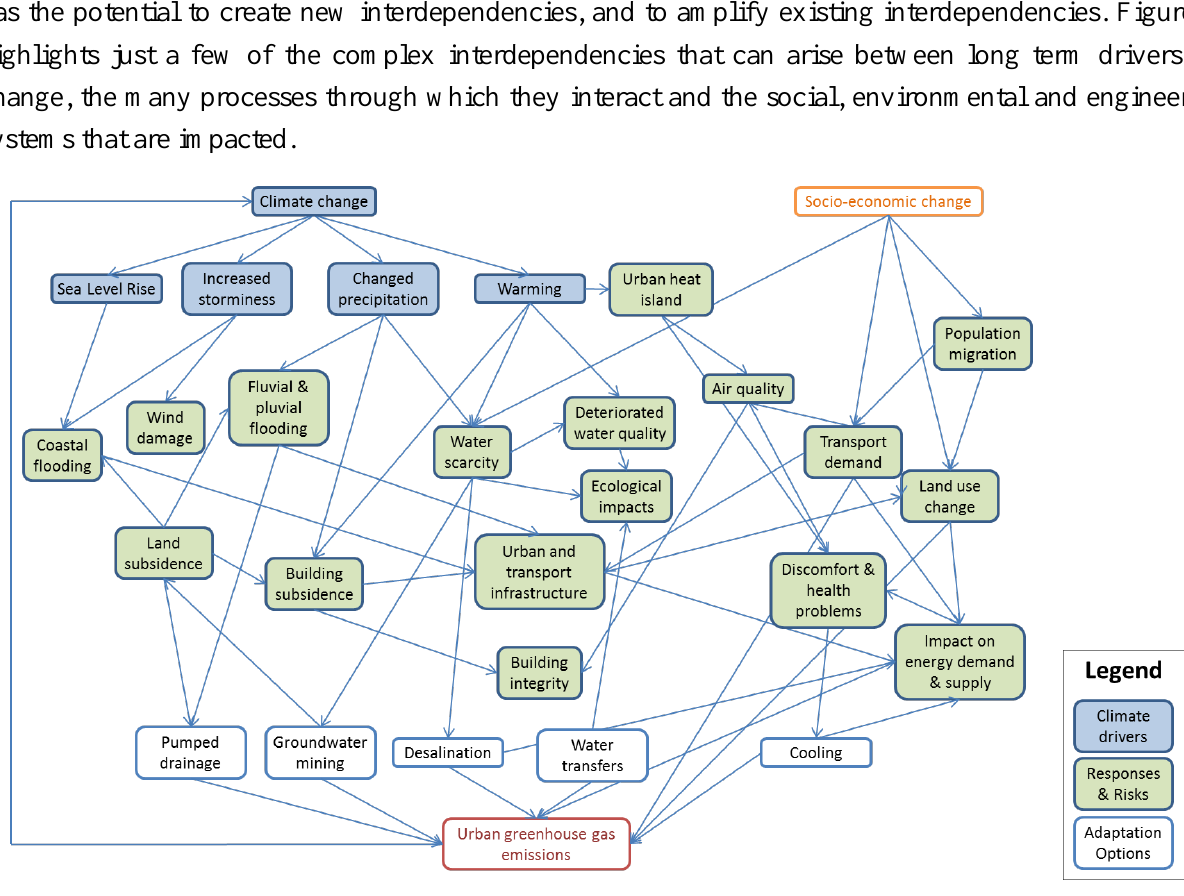
Figure 1 . Some examples of interdependencies arising from climate change risks (adapted from